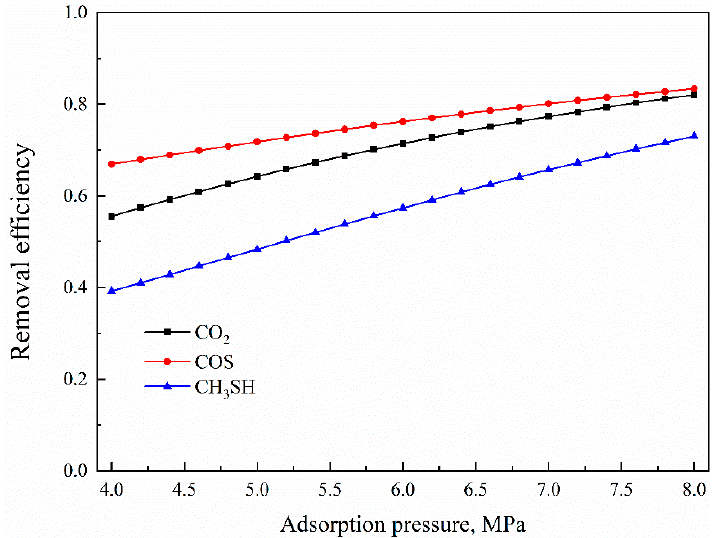
Figure 14. The effect of absorption pressure on removal efficiency (number of plates: 25; overflow weir height: 0.15 m; inlet gas flow rate: 5.0 × 10 6 Nm 3 /d; inlet gas–liquid ratio: 600; inlet gas loading: CO 2 , 4.5 vol.%; H 2 S, 1.5 vol.%; COS, 15 mg/m 3 ; CH 3 SH, 15 mg/m 3 ).